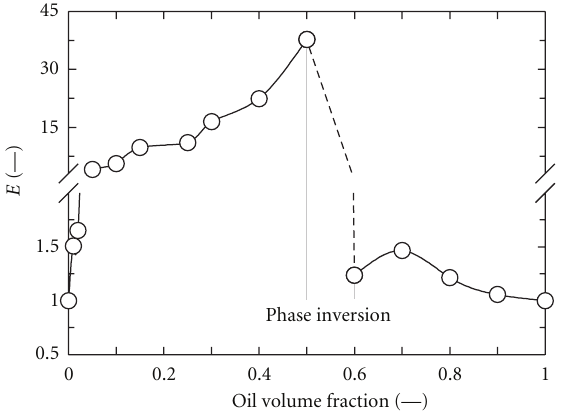
Figure 10: Variation of the mass transfer enhancement factor E with the n-heptane volume